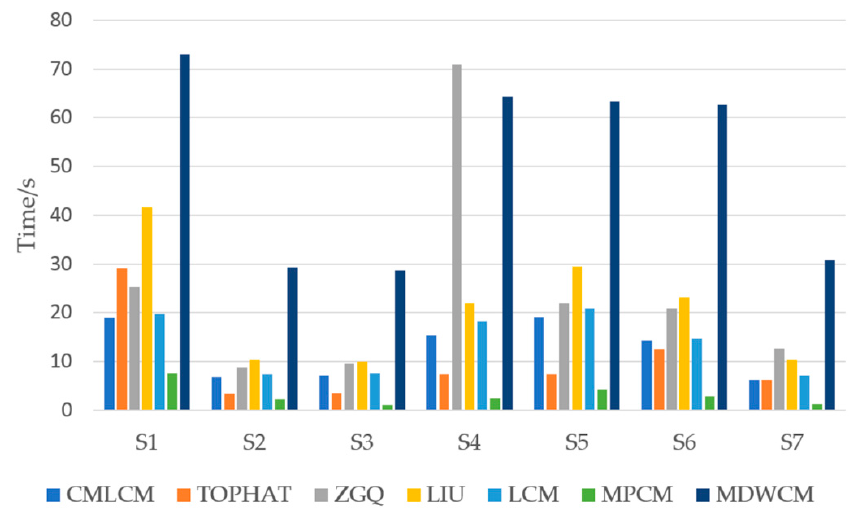
Figure 15. The time consumption of seven sequences for different algorithms.